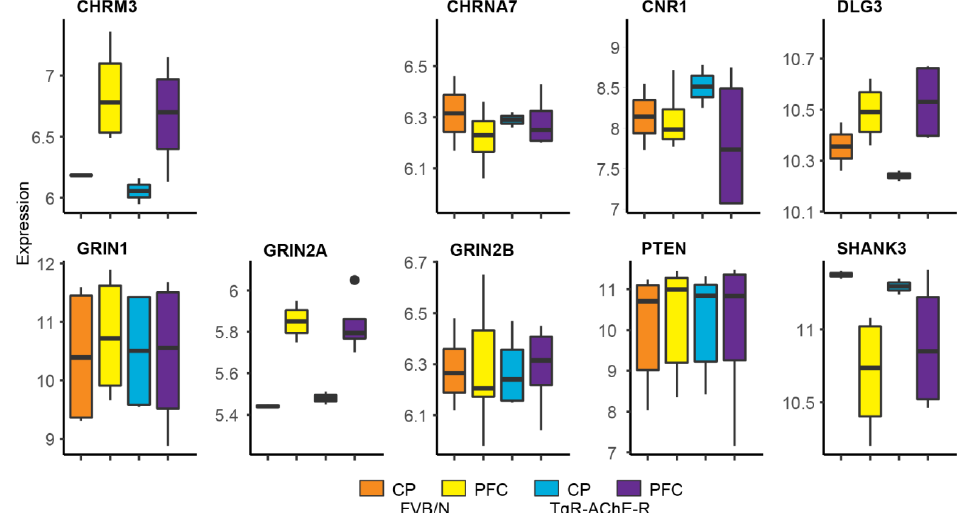
Figure 6. Microarray-validated individual diversity in PFC’s cholinergic-related transcripts compared to the CP. Shown are variabilities between the CP and the PFC in FVB/N mice and the TgR strain. Higher individual variability can be seen in the expression profiles between the PFC and the CP, especially in the SB-prone TgR strain.